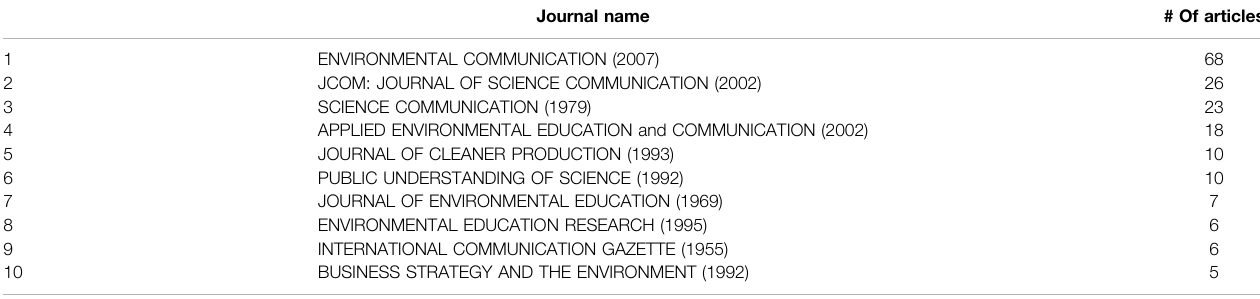
TABLE 2 | The top 10 journals for environmental communication from 1970 – 2019 include a wide range of journals. The fi rst year of publication for each journal is listed in parentheses, obtained from UlrichsWeb Global Serials